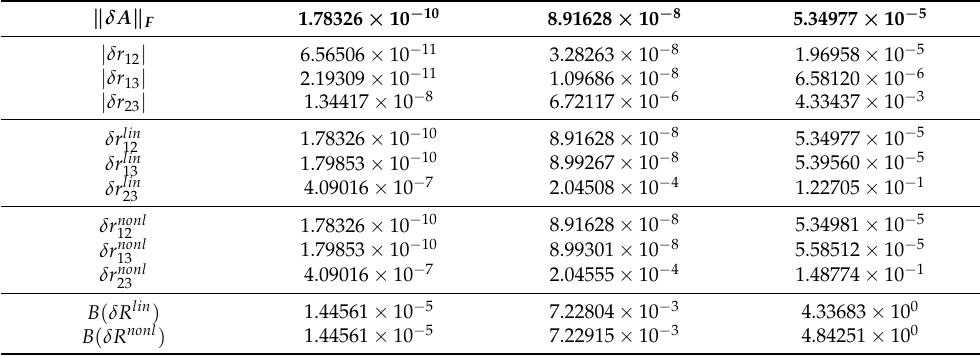
Table 6. Exact perturbations of the super diagonal elements of R and their linear and nonlinear